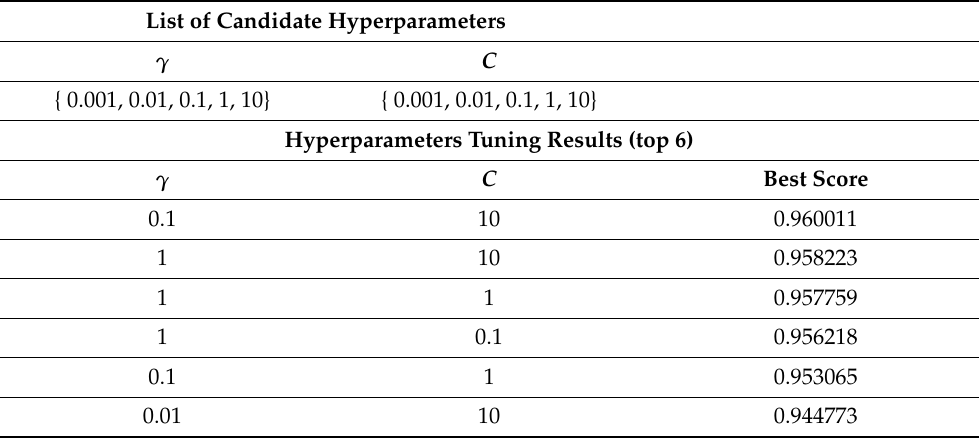
Table A3. The list of candidate parameters and parameters tuning results for finding the optimal parameter set in SVM.